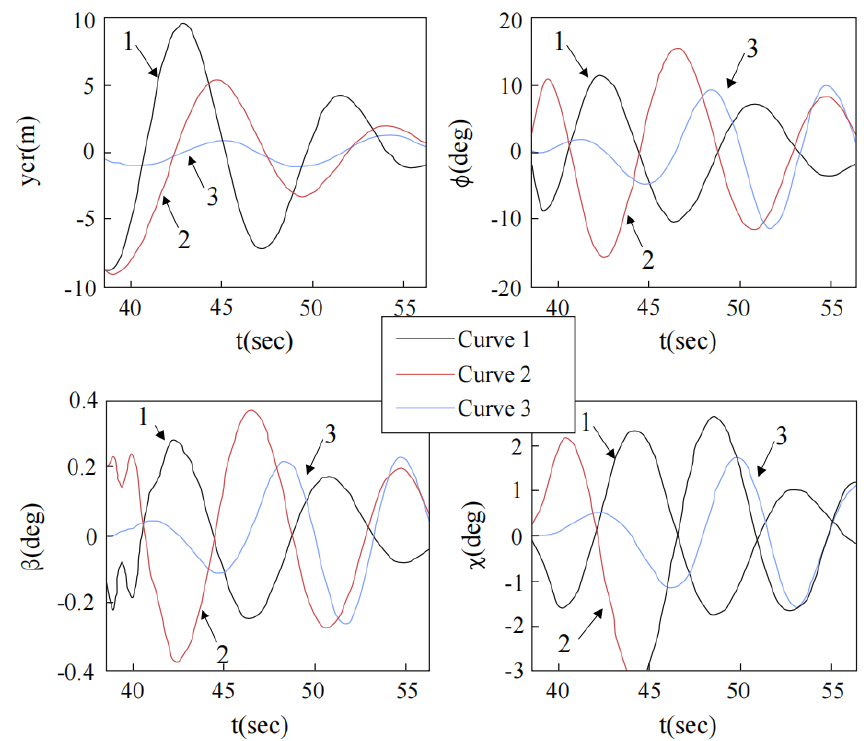
Figure 35. The curves of the compensation of deck motion under integral tracking strategies with different k values.